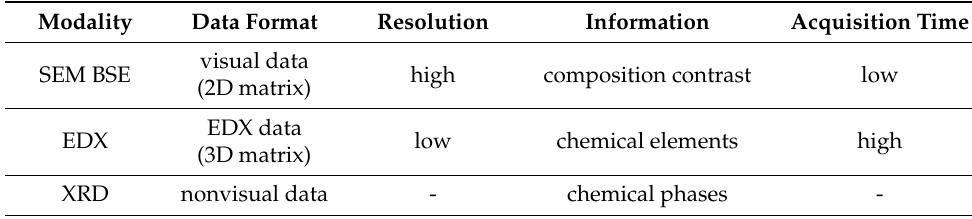
Table 2. Characteristics of the modalities SEM BSE, EDX, XRD.